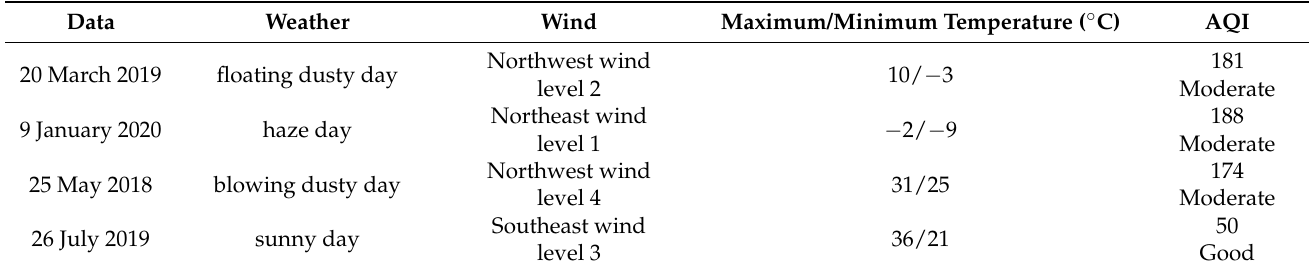
Table 1. The weather conditions, floating dusty days, blowing dusty days, hazy days and sunny days in Yinchuan area. Data